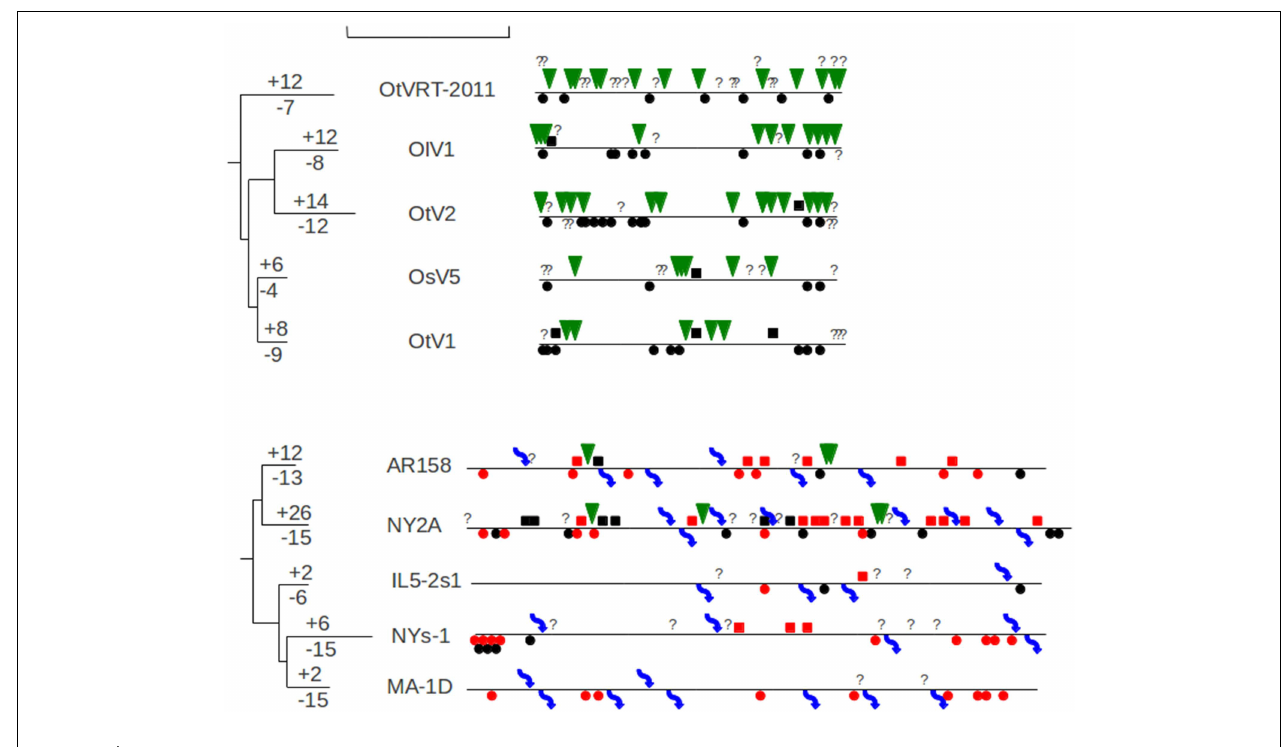
FIGURE 3 | Genomic map of the Chlorella and Ostreococcus Phycodnaviruses describing the different genomic mutations that have occurred after the divergence with their last common ancestor. Symbols below the line indicated gene losses (dots for gene losses, arrows for excision of mobile genetic elements) and symbols above the line indicate gene gains (squares for duplications, triangle for LGTs and arrows for